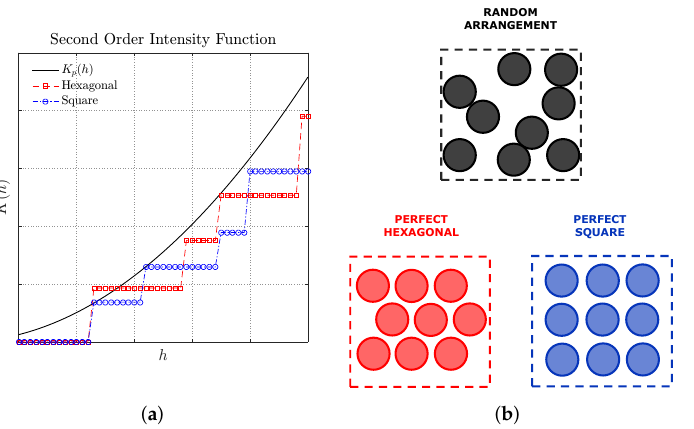
Figure 1. Response of the second-order intensity function K ( h ) , or Ripley’s K-Function, expected for arrangements with same number of fibers and same area of study ( a ), distributed in random, hexagonal, and square patterns ( b ). Adapted from [52].